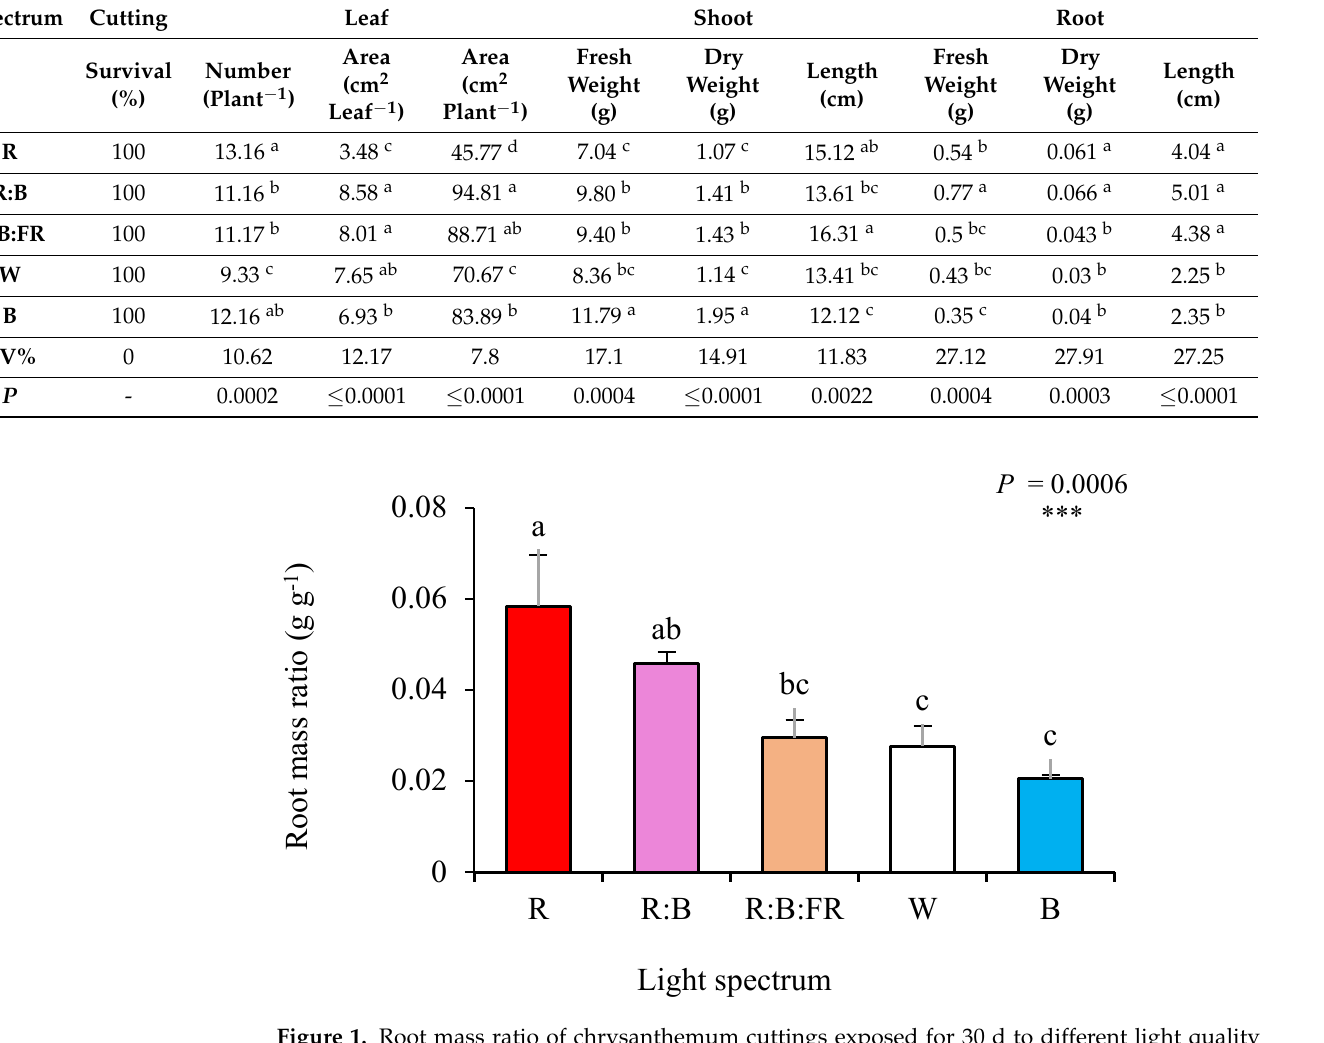
Figure 1. Root mass ratio of chrysanthemum cuttings exposed for 30 d to different light quality regimes (red (R), red and blue (R:B), red, blue and far-red (R:B:FR), white (W) and blue (B); see the spectrum in Figure 9). During the experiment, the photosynthetic photon flux density was set to 150 ± 5 µ mol m − m s − s . Six replicates per treatment were assessed. Columns with the same letters are not significantly different at p ≤ 0.05, according to Duncan’s multiple range tests. Bars represent SEM.